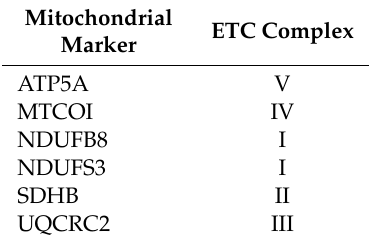
Table 1. Mitochondrial components and related electron transport chain complexes assayed in purified small extracellular vesicles by Western immunoblotting. Mitochondrial ETC Complex Marker ATP5A